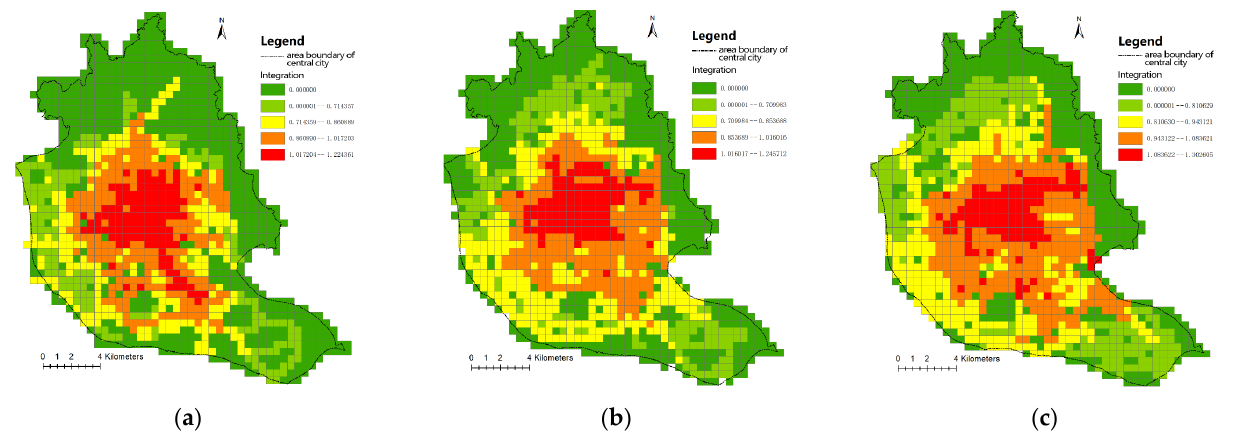
Figure 4. Urbanization intensity in Fuzhou (street global integration: ( a ) Urbanization intensity in 2000; ( b ) Urbanization intensity in 2010; ( c ) Urbanization intensity in 2021. Red represents the highest level of integration; green represents the lowest.